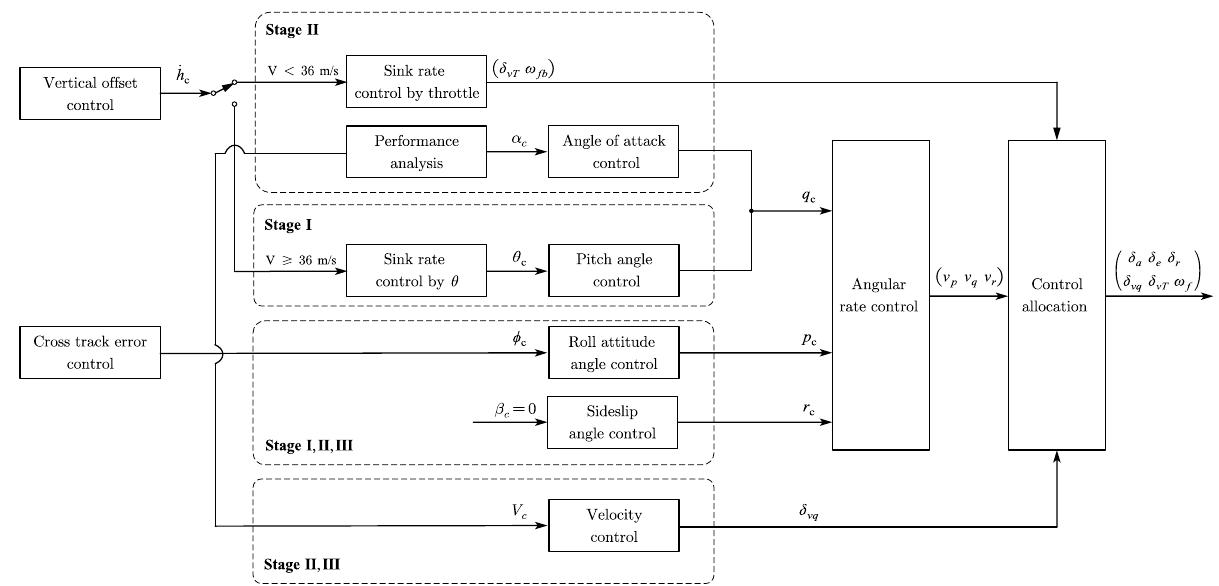
Figure 18. Overall control structure for short